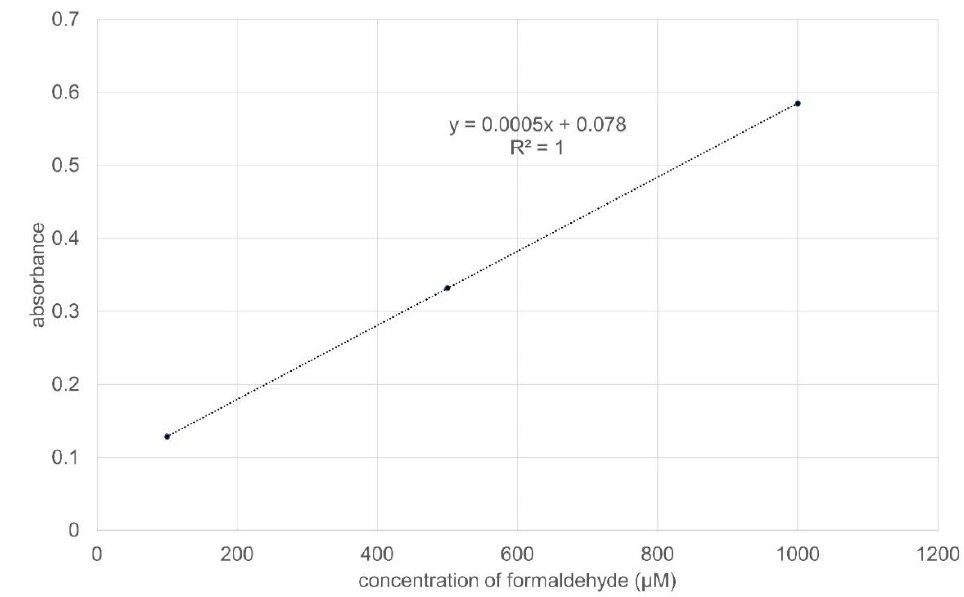
Figure A10. Calibration curve to determine the activity of CYP 3A4 enzyme in rat small intestine.